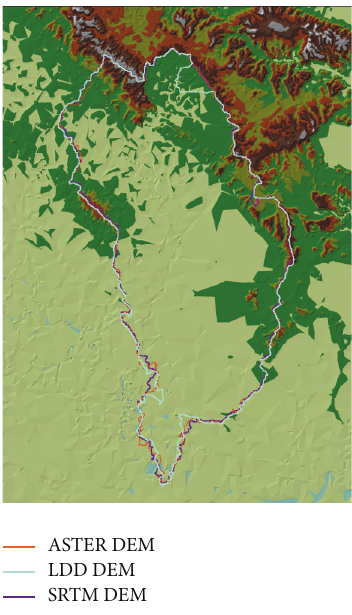
Figure 5: Watershed delineation for Nam-Yang subbasin.